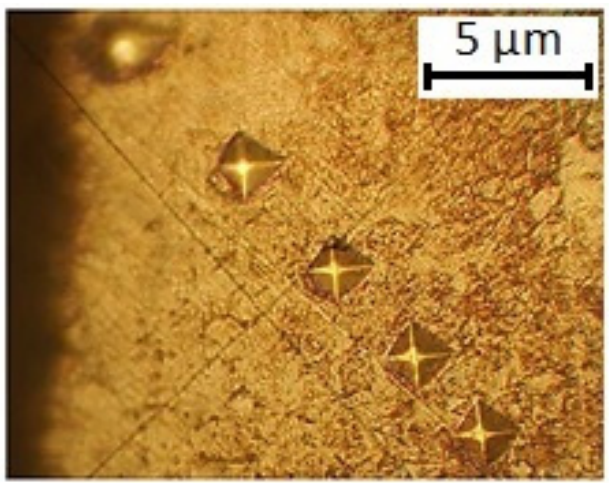
Figure 5. A nitrocarburized layer with imprints of measured microhardness.